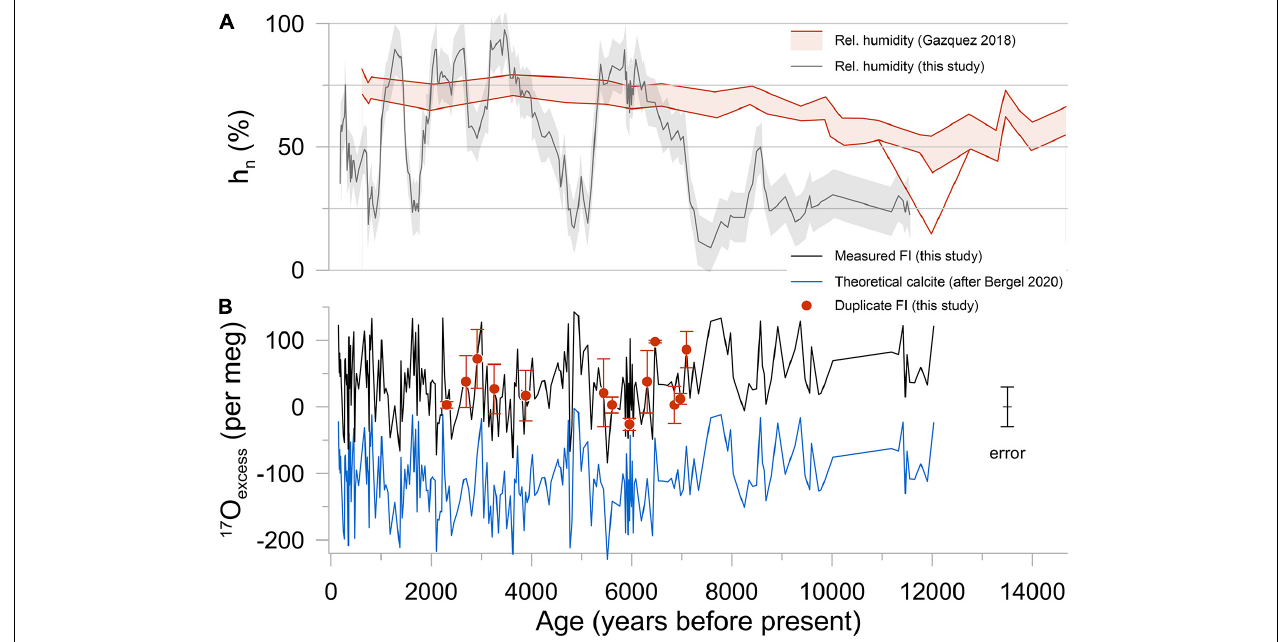
FIGURE 9 | Tentative reconstruction of the relative humidity and the calcite 17 O excess values. (A) Relative humidity estimation. The gray line is h n calculated from our speleothem fluid inclusion 17 O excess data (following Sha et al., 2020; 9 value running average) and the red line is the reconstructed h n from Lake Estanya (Gazquez et al., 2018). (B) Calculation of theoretical (cid:49) 17 O of the calcite (blue line) based on measured 17 O excess of the water (black line according to Bergel et al. (2020). Speleothem duplicate measurements (red dots) as given in Table 2 . FI stands for fluid